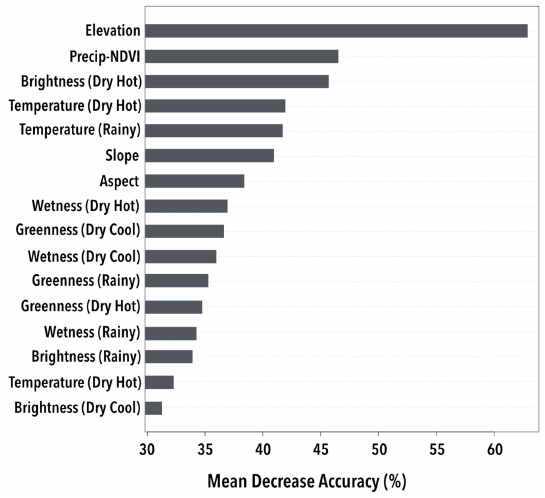
Figure 5. Variable importance analyses for the full model (% change in mean accuracy, S+TP , mtry = 3, N =